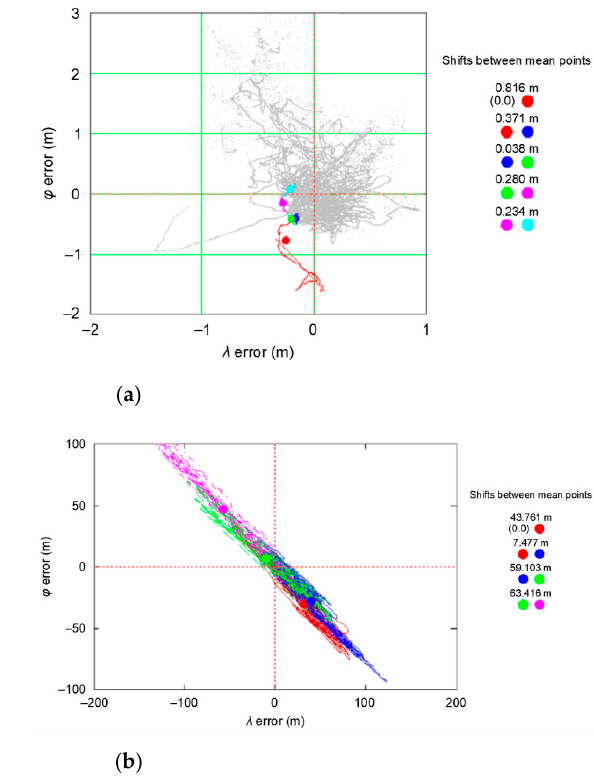
Figure 9. PRW process based on the example of ( a ) EGNOS; ( b ) Decca Navigator.